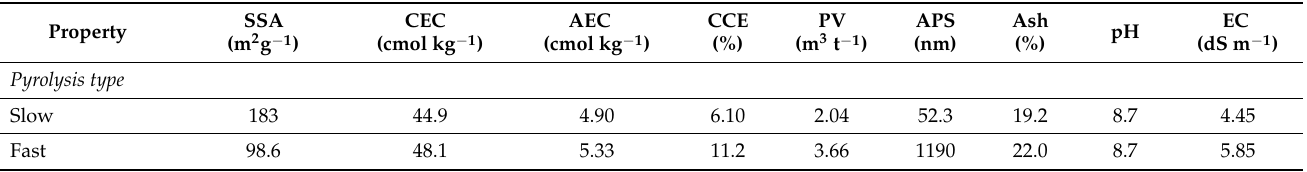
Table 2. Basic biochar physicochemical and morphological properties (expressed on a dry basis)